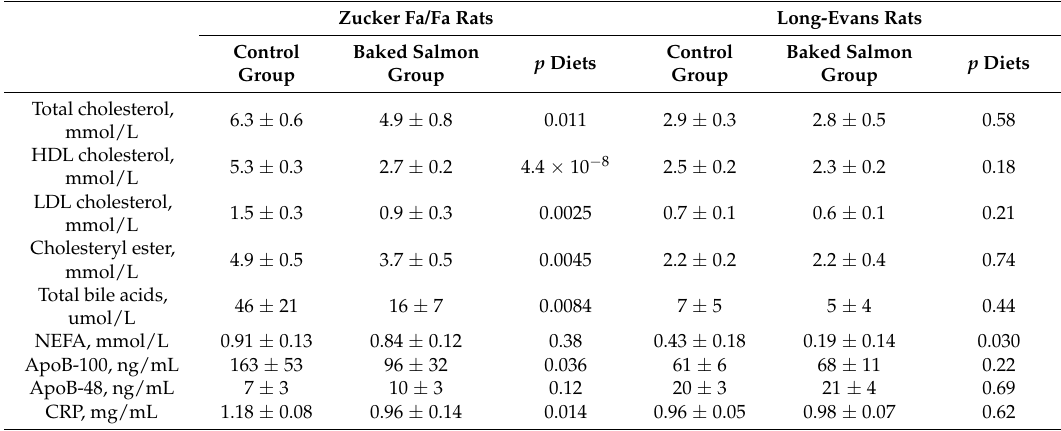
Table 4. Serum concentrations of lipids, total bile acids, apolipoproteins B48 and B100, and CRP. Zucker Fa/Fa